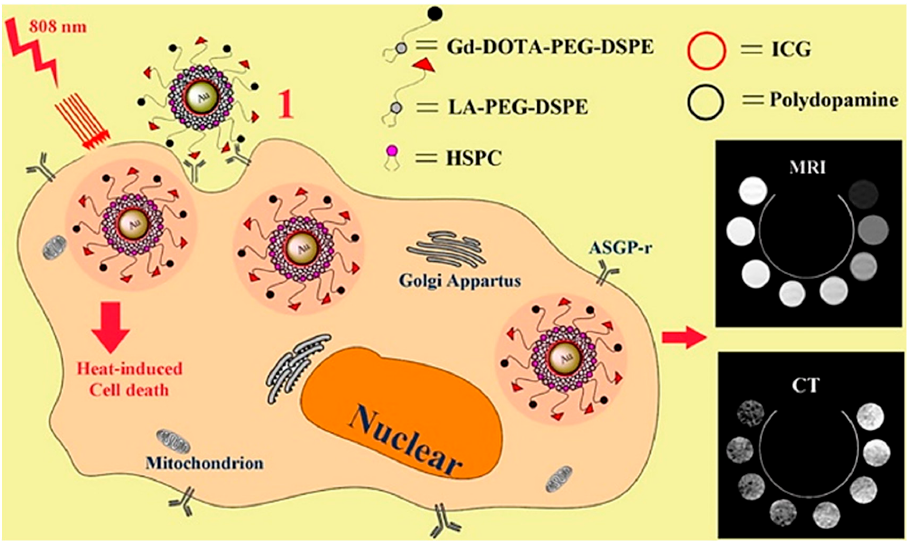
Figure 5. Gold NPs which were coated with PDA, indocyanine green, and modified lipids Figure (gadolinium-1,4,7,10-tetraacetic acid and lactobionic acid) were used for targeted magnetic resonance